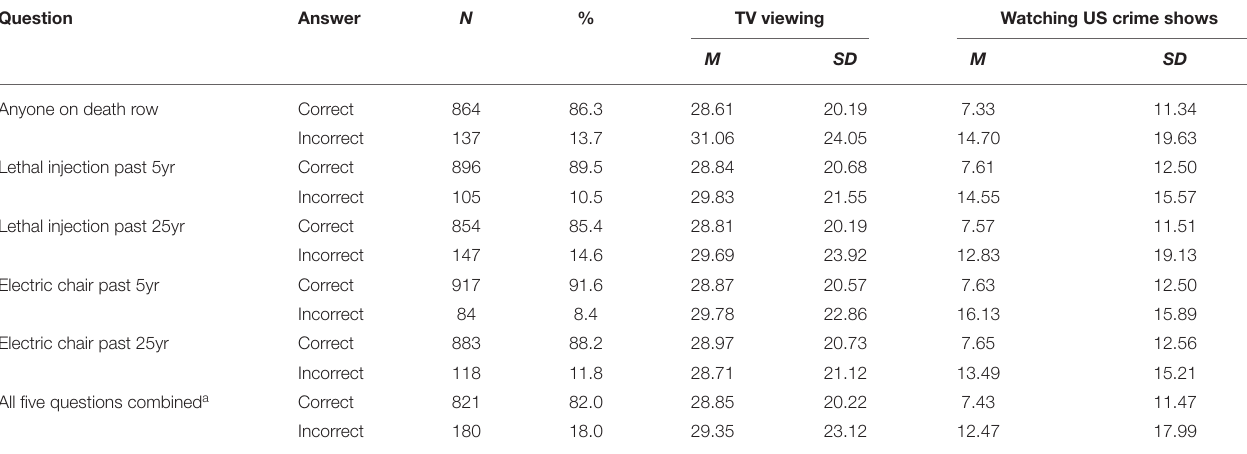
TABLE 1 | Descriptive statistics of perceptions of the death penalty and television viewing among study participants ( n = 1001).